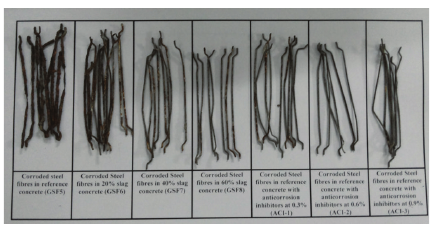
Figure 13: Snapshot of corroded steel fibres in different concrete mixes containing slag and corrosion inhibitor.